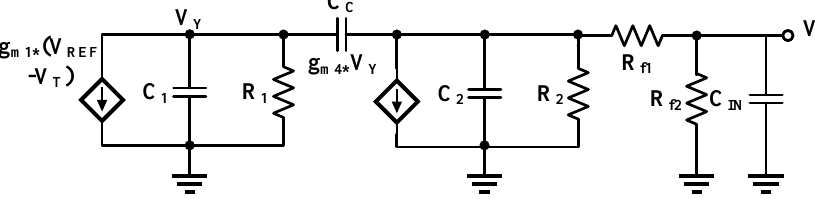
Figure 10. Small-signal macromodel of the LDO for the calculation of the phase